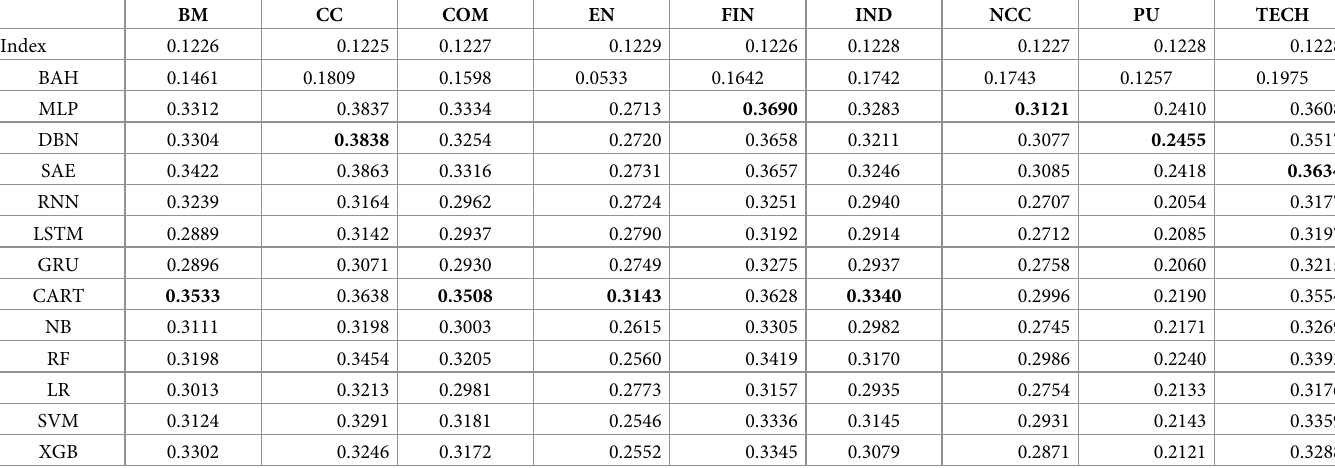
Table 5. Comparison of the ARR of various trading strategies in the different industries of SPICS. Best performance is in boldface.